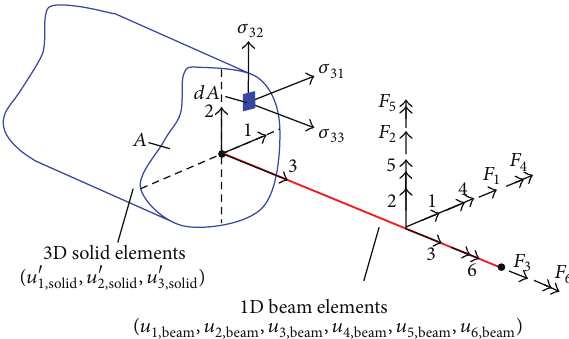
Figure 1: Coupling of 1D element with 3D